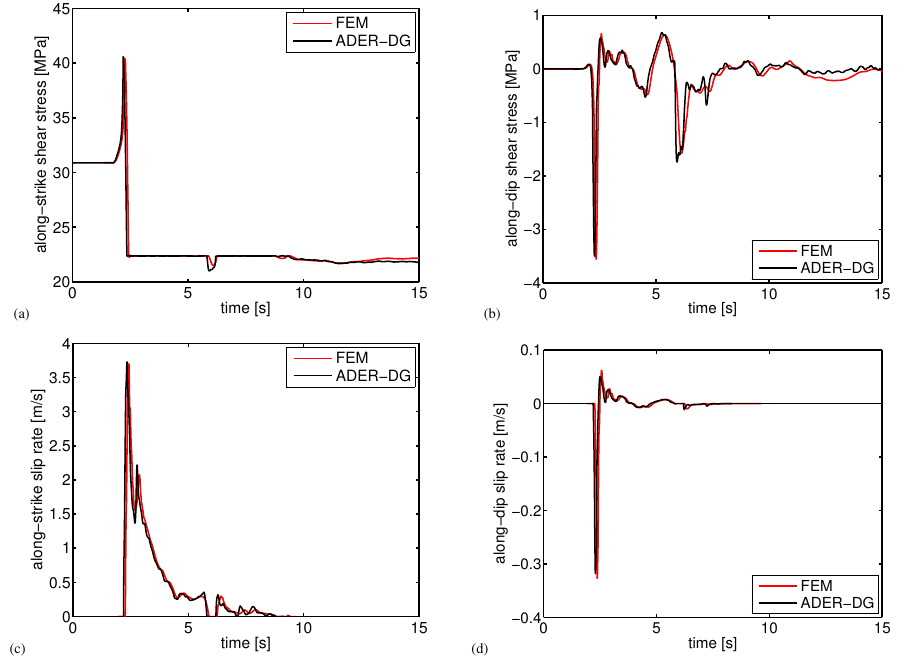
ADER-DG solution is shown in black, the FEM comparison solution in red.